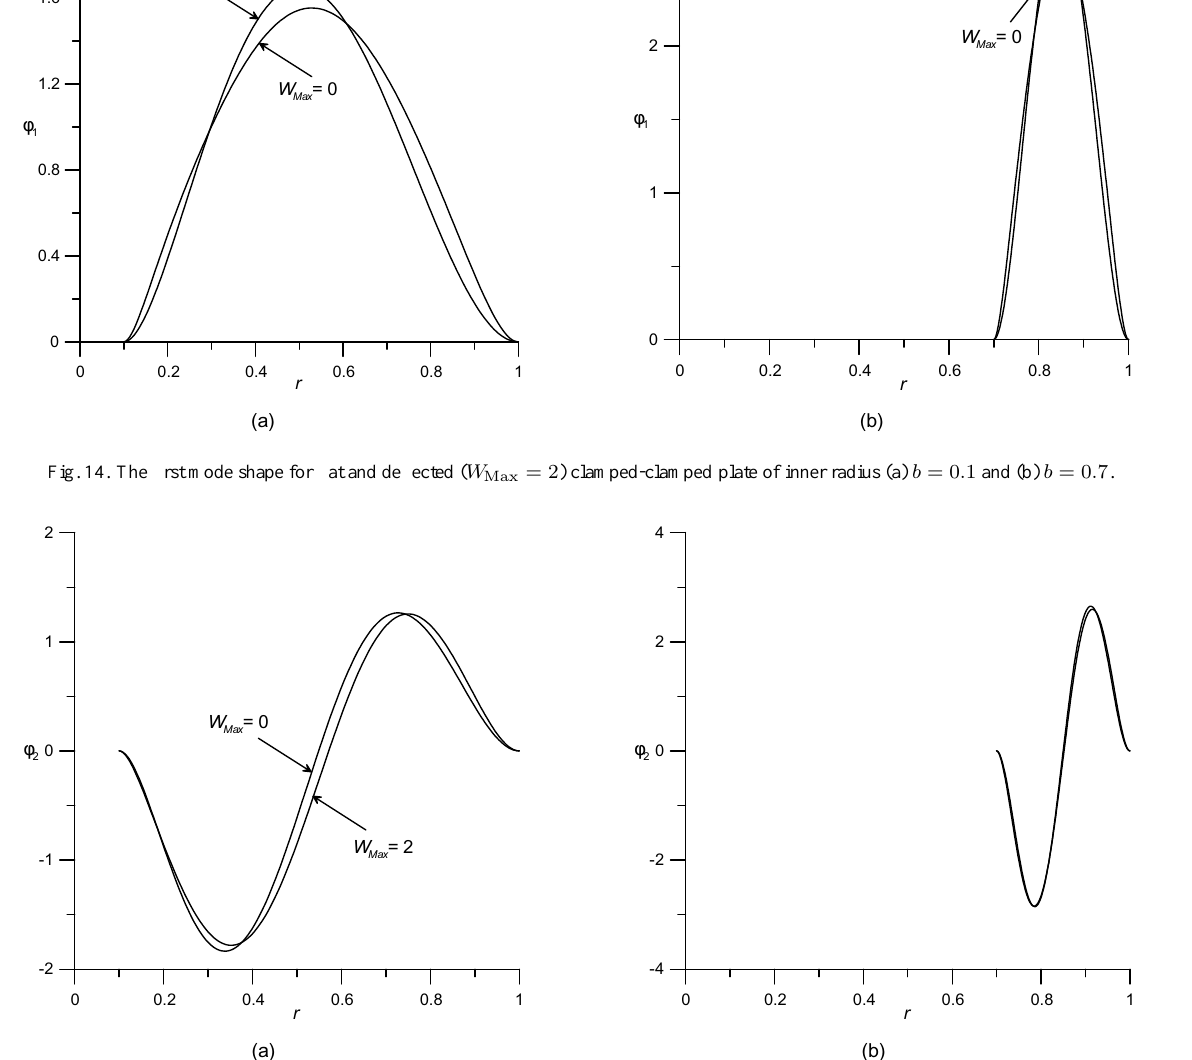
(clamped-clamped boundary conditions) for a flat and a deflected ( W Max = 2 ) plate in each